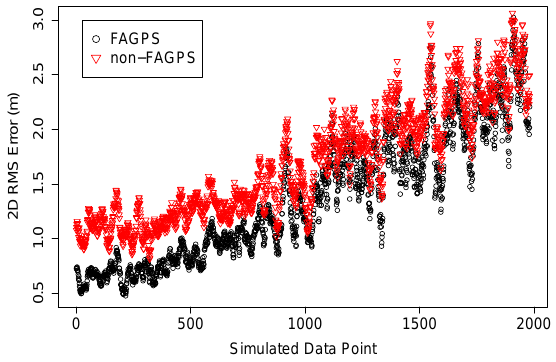
Figure 7. Simulation shows the FAGPS starts with a significantly lower error which over time becomes similar to the non-FAGPS